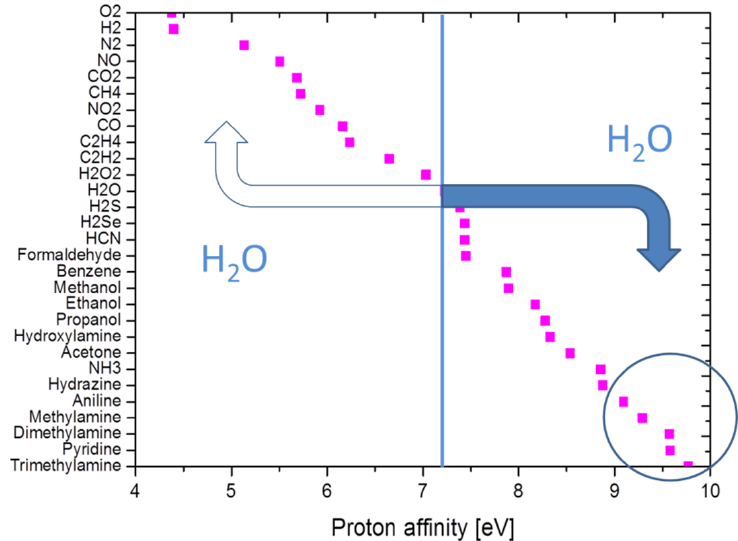
Figure 5. Proton affinity of selected molecules. The blue line highlights the proton affinity of water, i.e. , the energy released in the gas phase reaction H 2 O + H + → H 3 O + . Starting from H 3 O + ions, protons will be transferred to higher proton ‐ affinity molecules (filled arrow) in the course of gas ‐ kinetic collisions, while a transfer to lower proton ‐ affinity ones is extremely unlikely (empty arrow).